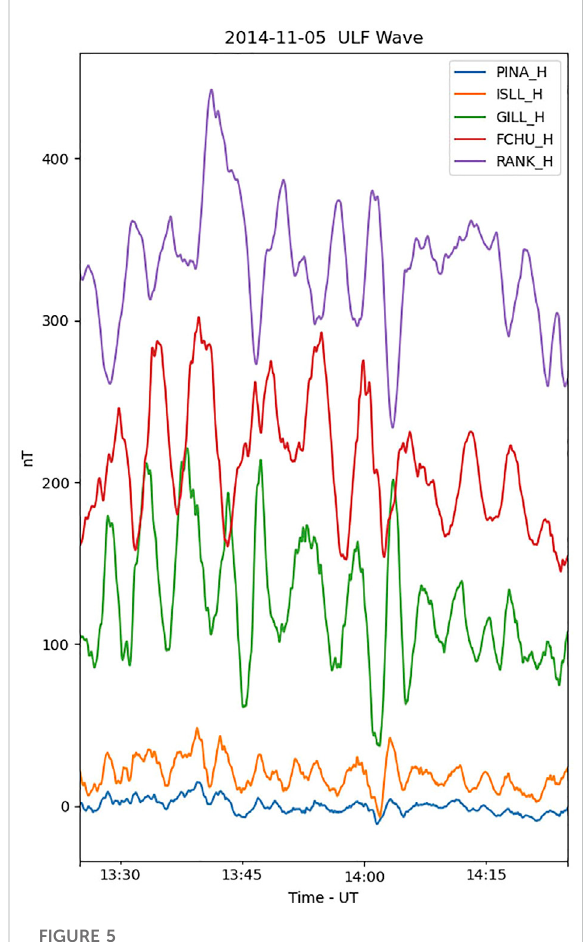
FIGURE 5 Multi-station stacked plot of a ULF wave observed by select CARISMA magnetometer stations that are a part of the Churchill line. The plot was generated using Pandas and